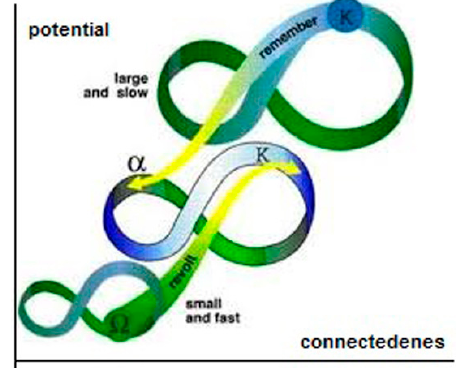
Figure 1. Panarchy theory: phases and dynamic cross-scale interactions. Source: Shannon 2015 [8].